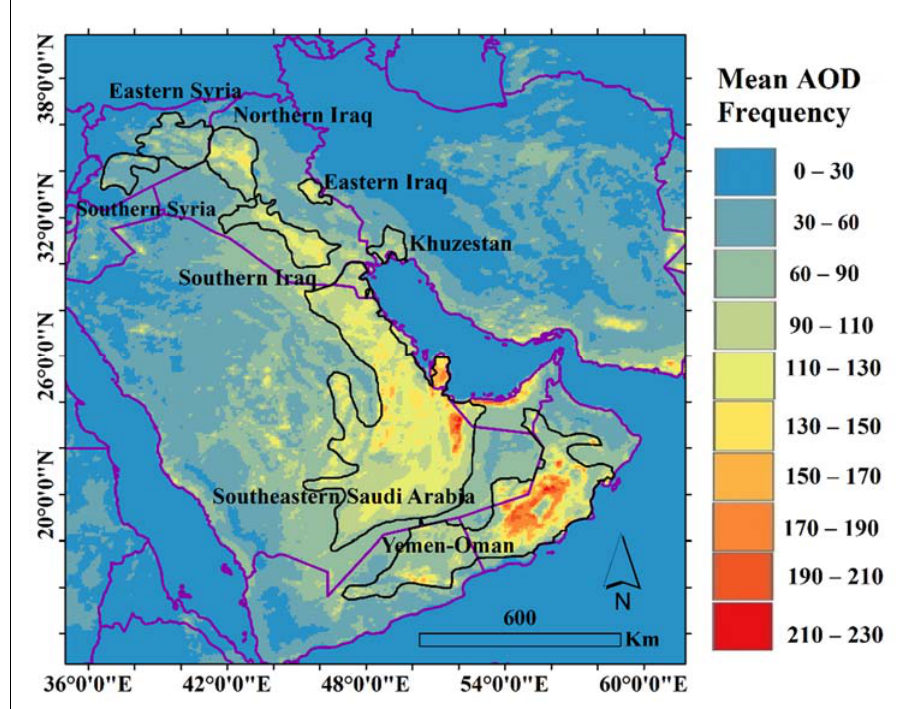
Figure 3. Eight dust hotspots labeled by name were computed based on the mean annual frequency (in days) of MODIS AOD exceeding 0.6 between 2000 and 2019.